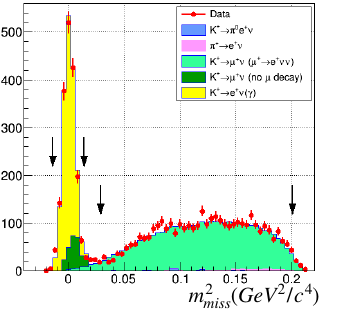
Figure 2. Distributions of m 2 for data and simulated events passing the (left) e + and (right) µ + miss selections (bin widths of 0.004 GeV 2 ). Pairs of vertical lines in each plot indicate the boundaries of the SM and HNL signal